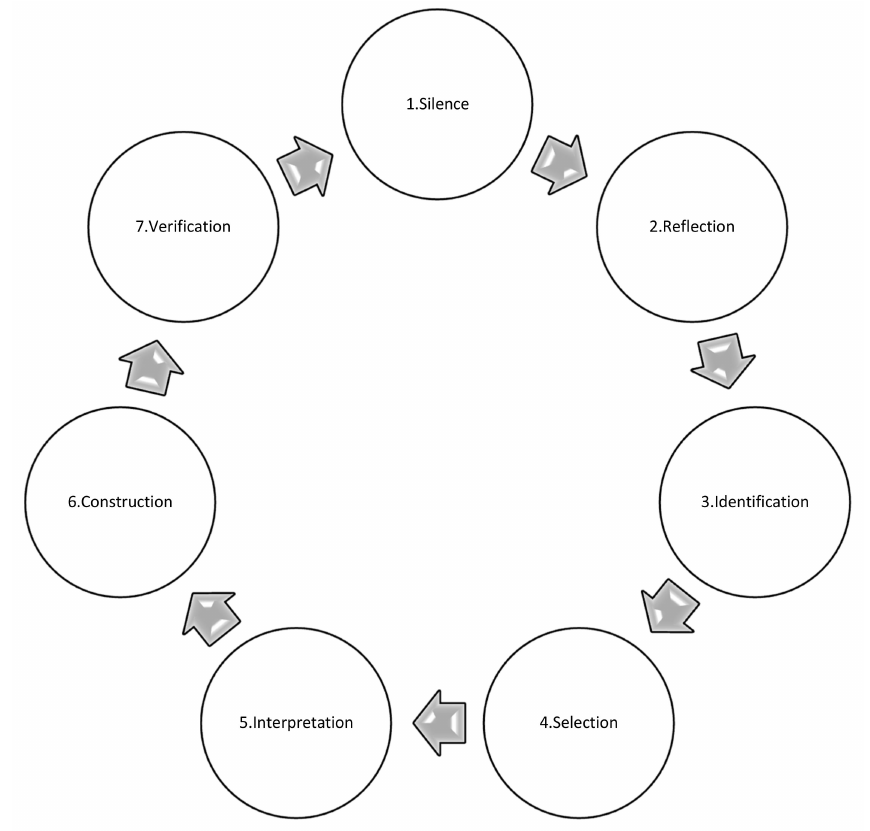
Figure 1. The process of doing phenomenology in the Vancouver School [45]. In every step of the 12 steps of the Vancouver School, this cycle is